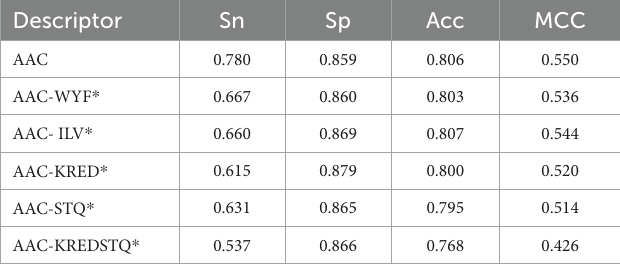
TABLE 3 Prediction results of using different AAC descriptors for psychrophilic and non-psychrophilic